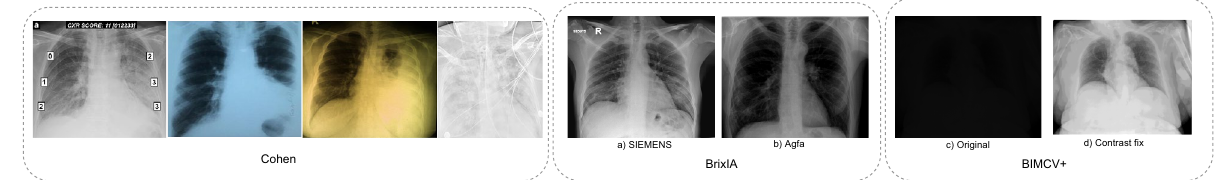
Figure 6. Examples of bias associated to capture conditions in different datasets.